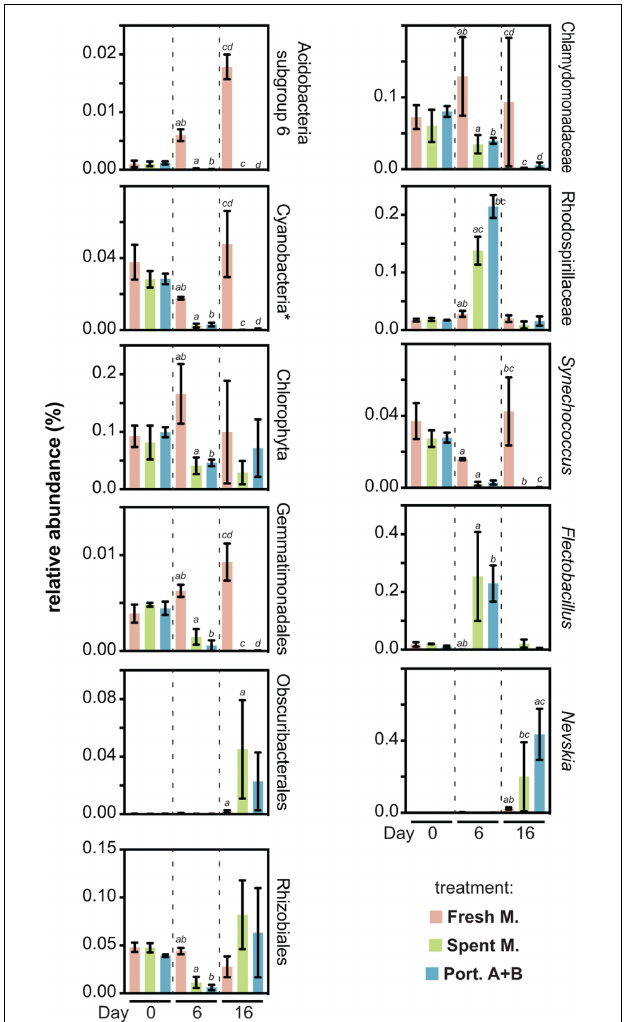
FIGURE 4 | Relative abundances of specific taxa found to be differentially impacted by the fresh medium, spent medium and/or portoamides treatments. For a given chart, pairs of bars labeled with the same letter denote statistically significant (95% confidence level) differences for the respective values. ∗ Excluding